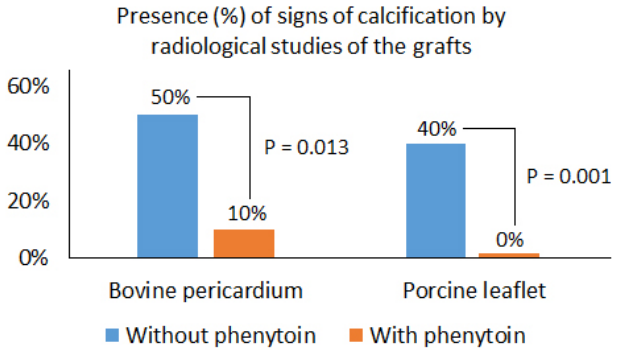
Fig. 7 - Presence of signs of calcification in radiologic studies of groups of bovine pericardium and porcine leaflets with and without phenytoin treatment.